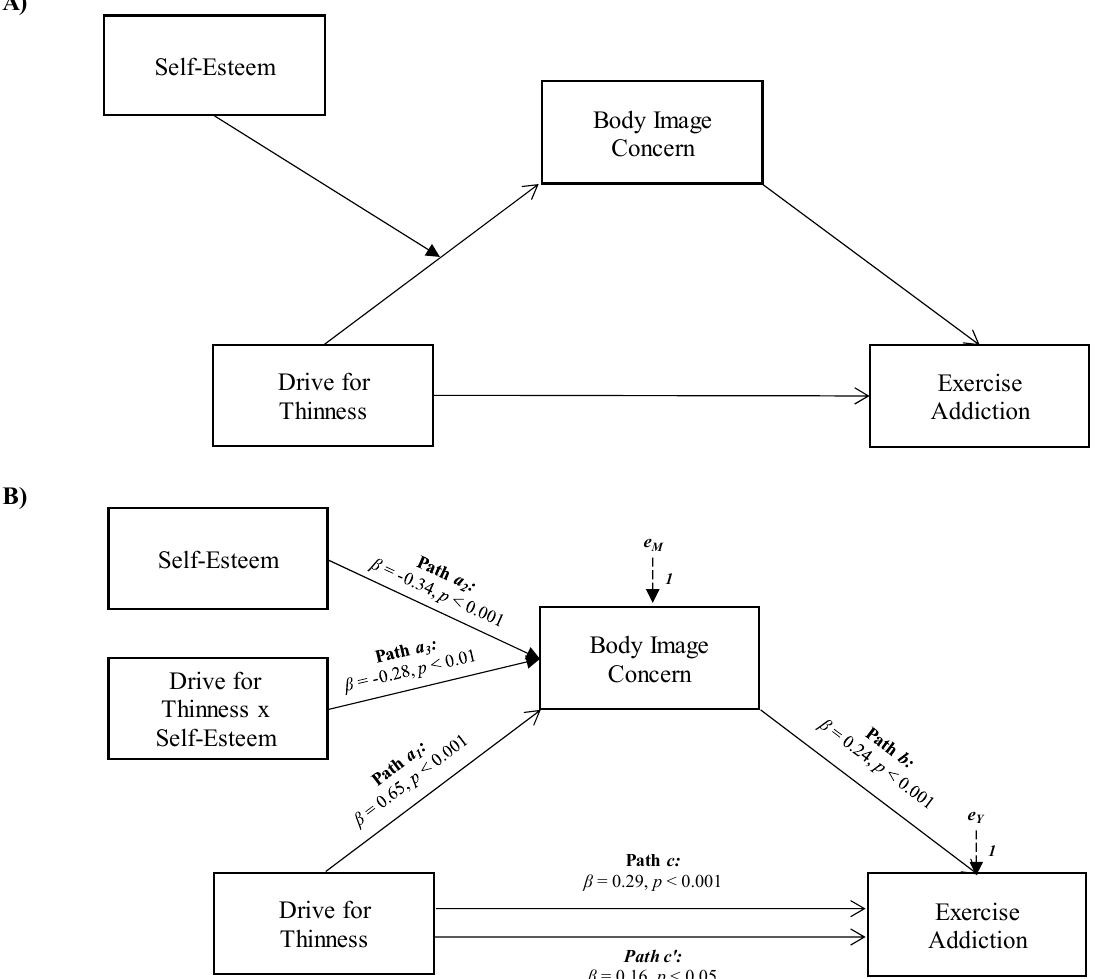
Figure 1. Statistical ( A ) and conceptual ( B ) forms of Model 1: A moderated mediation involving drive for thinness, body image concern, and self-esteem toward exercise addiction.